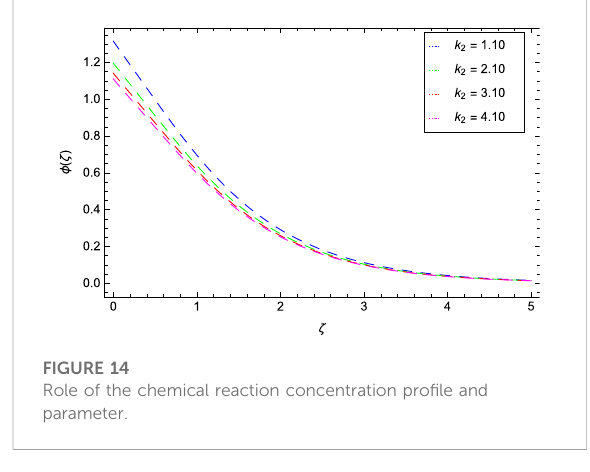
FIGURE 14 Role of the chemical reaction concentration pro fi le and parameter.